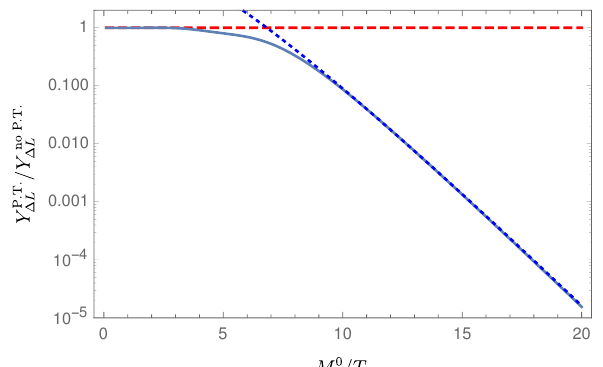
Figure 1 . Ratio of total lepton number asymmetry, Y (cid:1) L , with a (cid:12)rst-order phase transition relative to the constant-mass case. Only N I modes that are su(cid:14)ciently energetic to propagate through the bubble wall are considered for generating the asymmetry. The solid curve indicates the numerical solution of the Boltzmann equation, while the dotted blue line is a (cid:12)t to eq. (3.10), and the dashed red line illustrates the ratio of unity expected when T c is high enough that the N I equilibrate after the phase transition. For the speci(cid:12)c numerical results plotted here, we take M 1 = M 2 = 2 = 10 9 GeV, and the Yukawa matrices are chosen to be compatible with global (cid:12)ts to neutrino oscillations (see eq.